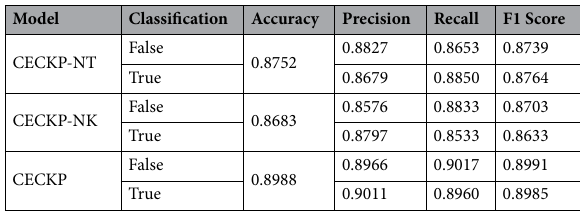
Table 4. Experimental results of model simplification test.